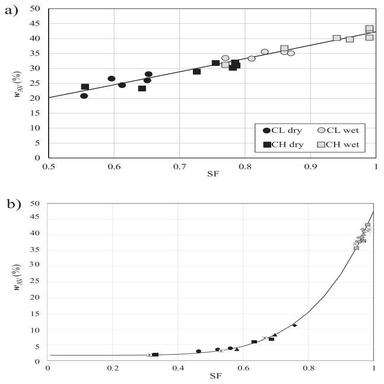
Calibration curves. (a) Natural soils. Black circles, CL dry profiles; black squares CH dry profiles; grey circles CL wet profiles; grey squares CH wet profiles. (b) Granular fill. Circles, Test 1; squares, Test2; triangles, Test 3; diamonds, Test 4; black symbols, dry conditions; grey symbols, wet conditions; asterisk, Test 5, dry conditions; cross, Test 5, wet conditions.